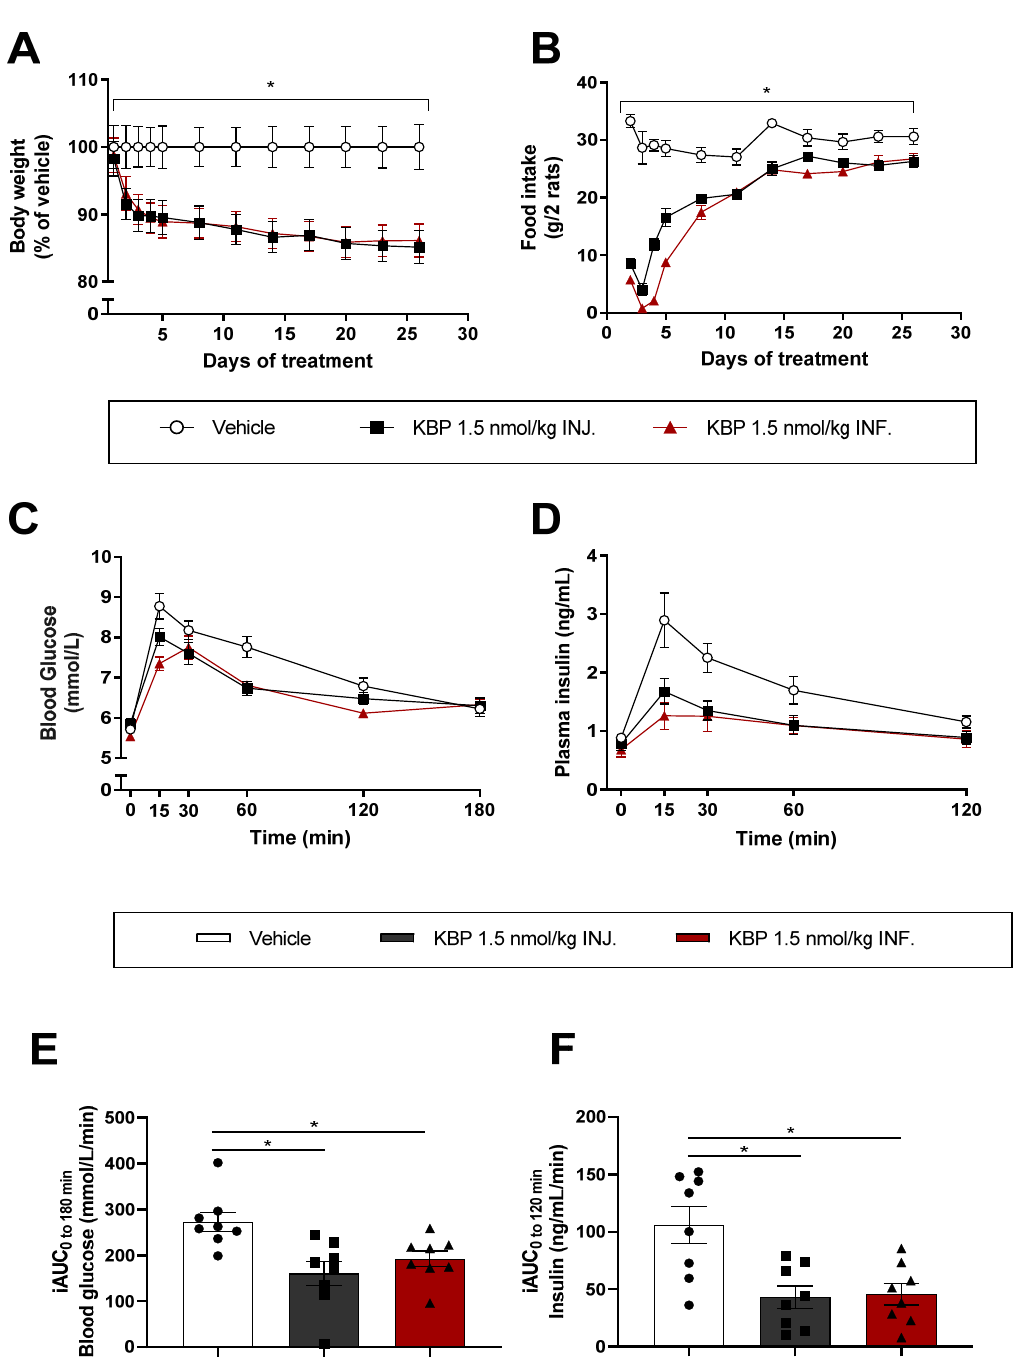
Figure 2. Infusion and injection of KBP in Sprague–Dawley rats. The rats were treated with KBP 1.5 nmol/kg/day delivered by s.c. injection (INJ) or continuous infusion (INF). ( A ) Body weight and ( B ) food intake were monitored once daily for 5 days, then every 3rd day. At study end (day 26), the rats were overnight (16 h) fasted and an OGTT was conducted. The rats were dosed 24 h prior to the glucose challenge. ( C ) Blood glucose and ( D ) plasma insulin were determined during the OGTT, as were the ( E ) iAUC of blood glucose and ( F ) iAUC of plasma insulin during the OGTT. Statistical analysis of tAUC of A) and B) was performed by one-way ANOVA with Tukey’s multiple comparison test. Statistical analysis in ( E ) and ( F ) was performed with one-way ANOVA with Tukey’s multiple comparison test. * p < 0.05 treatment(s) compared to vehicle. n = 8/group. Data are shown as mean ± SEM. Abbreviations: HFD—high-fat diet. INF.—(drug delivery by) infusion. INJ.—(drug delivery by) injection. tAUC—total area under the curve.